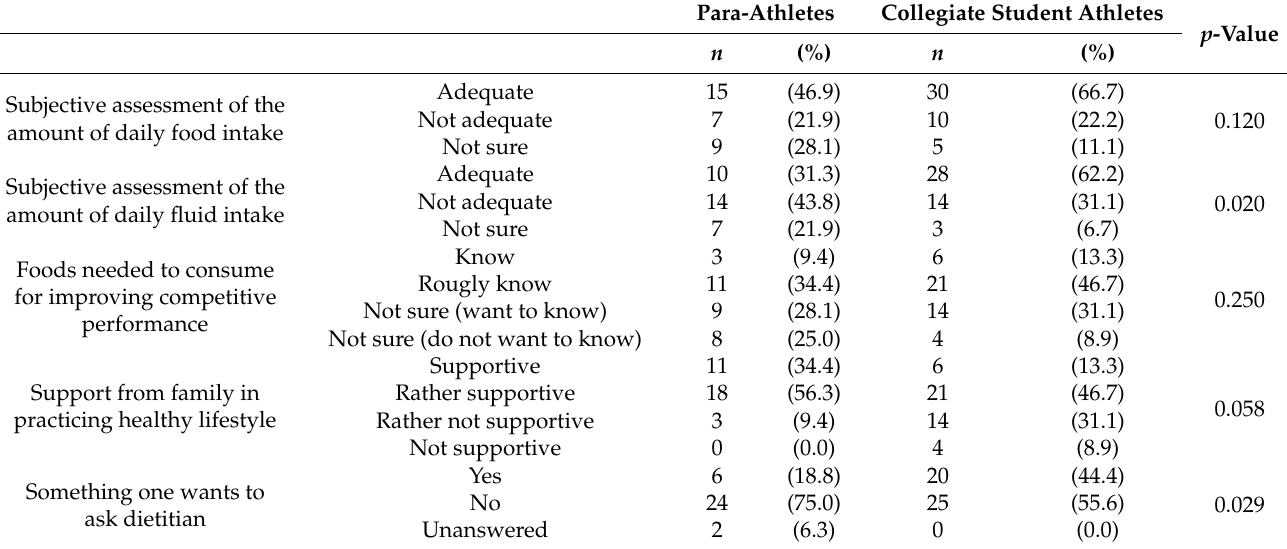
Table 5. Dietary practices in para-athletes and collegiate student